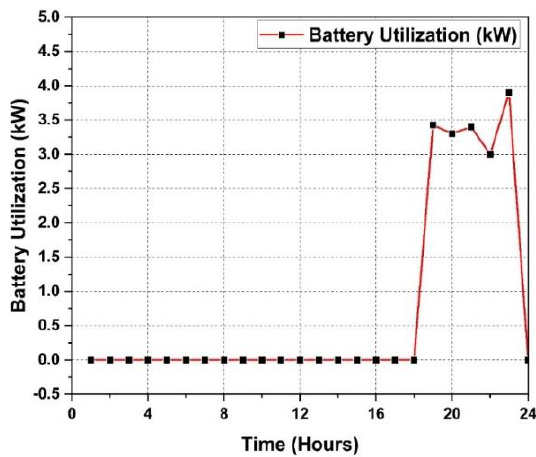
Figure 4. Battery utilization to load (off − Figure 4. B attery utilization to load (off− grid).